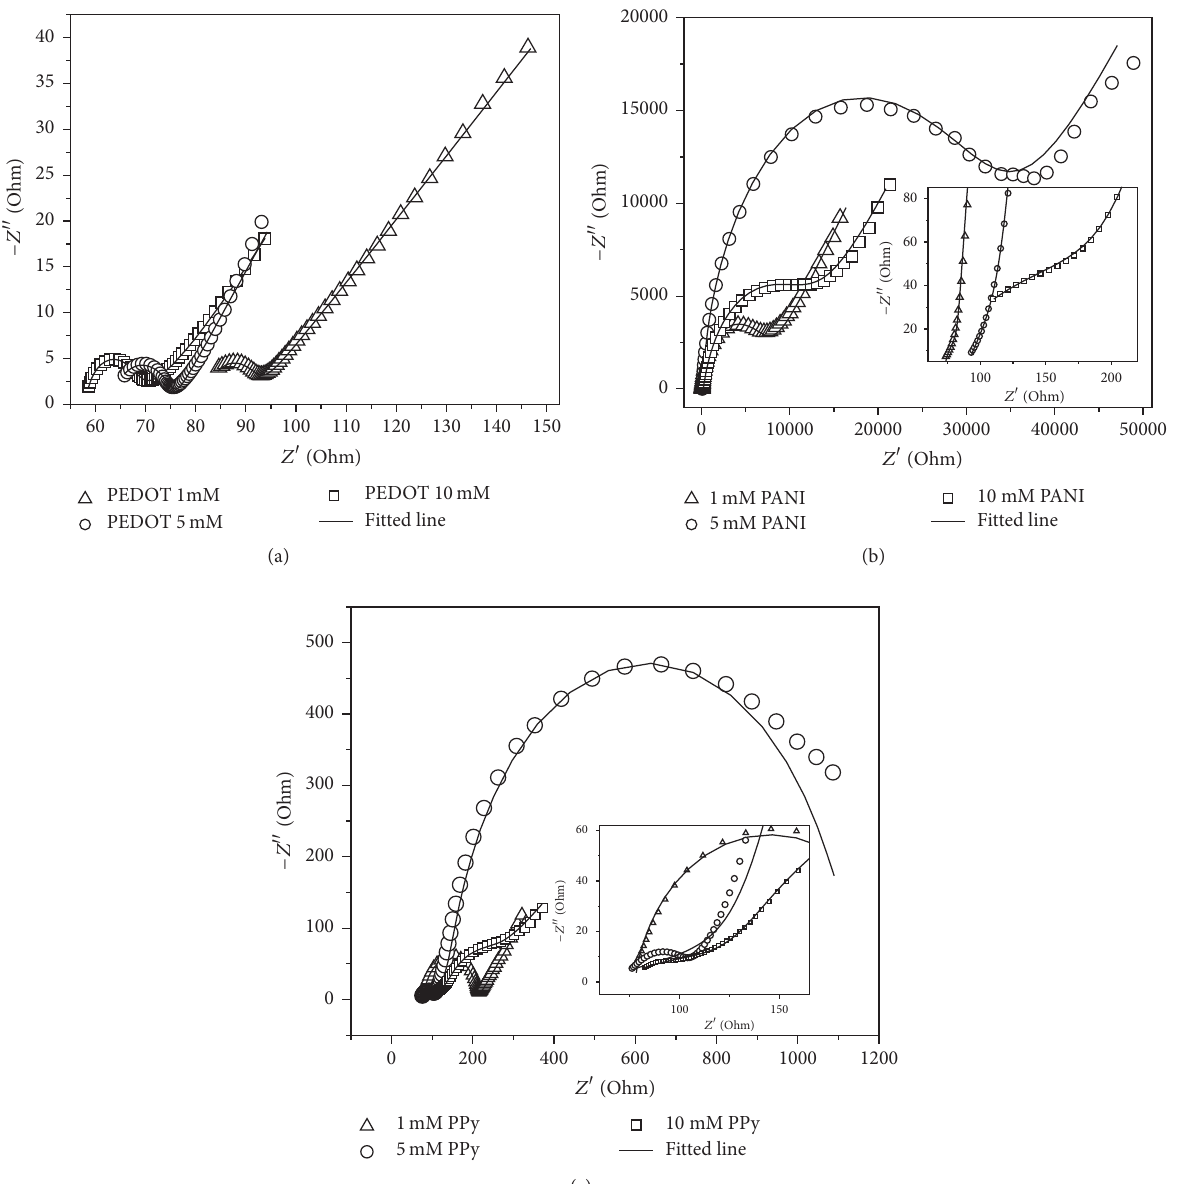
Figure 7: Nyquist plot of (a) PEDOT, (b) PANI, and (c) PPy deposited from the solution containing different monomer concentration on the ITO glass at 1.0V. The solid lines represent the best fitting according to the equivalent circuits (Inset: magnification of Nyquist plot at high-frequency region).